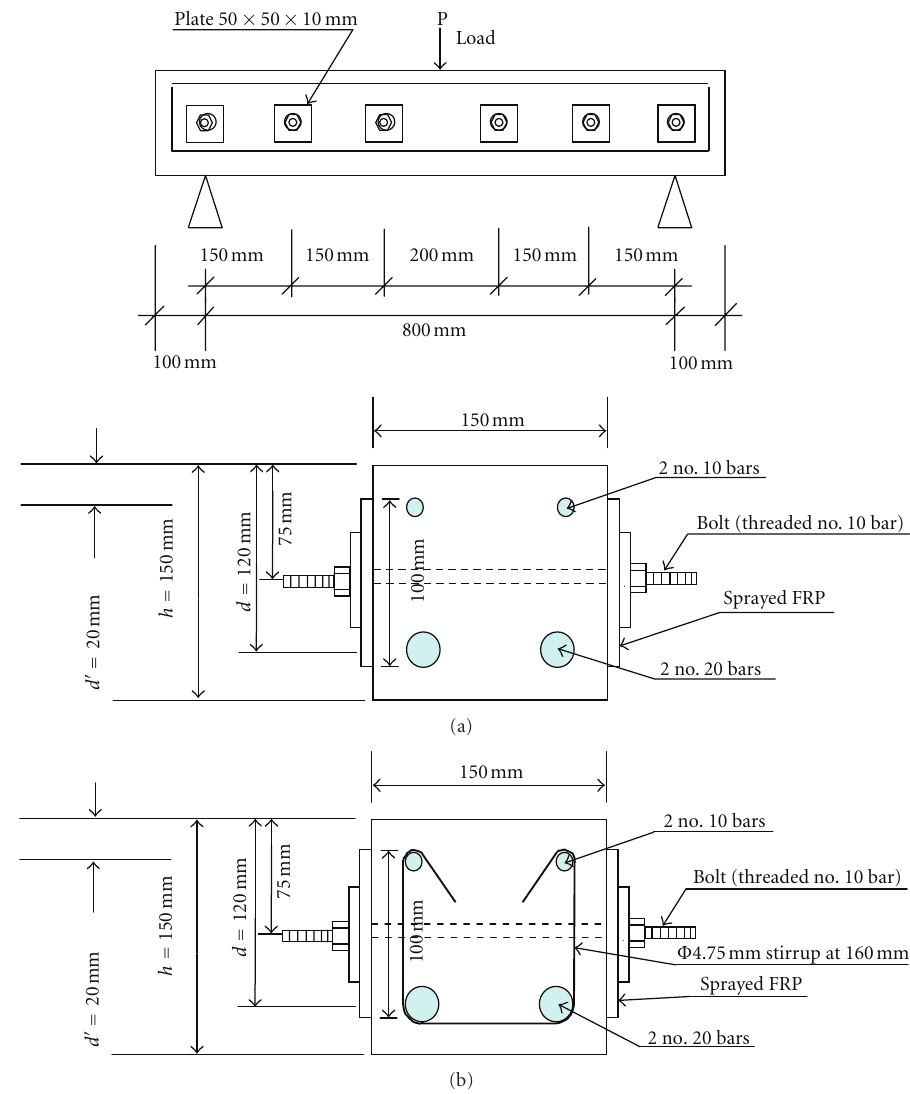
Figure 29: Cross-sectional details of RC beams; (a) B2-6B-NS-1 to B2-6B-NS-3; (b)